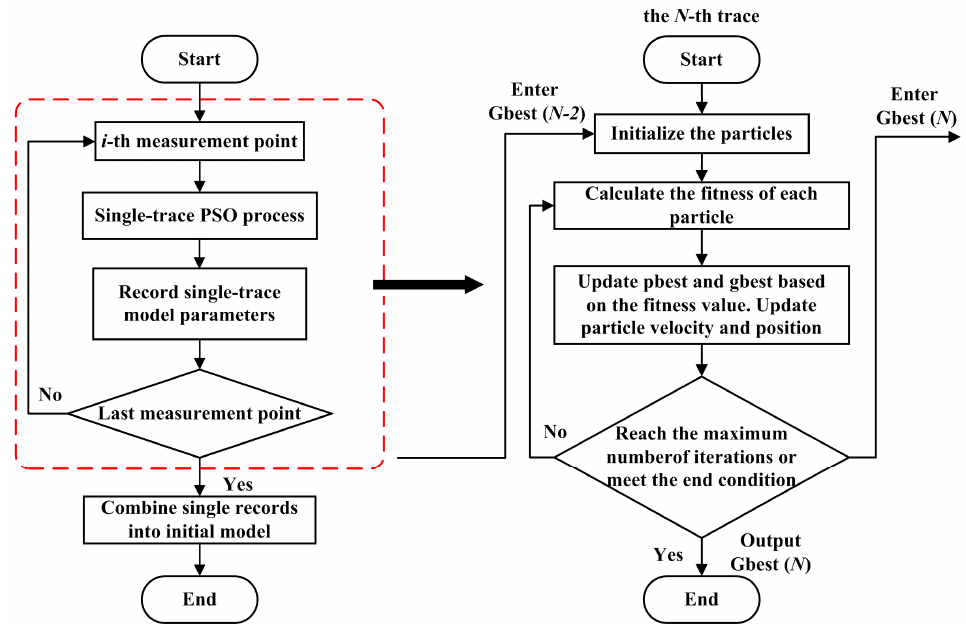
Figure 7. Flow chart showing the construction of an appropriate initial model using the single-trace PSO process.